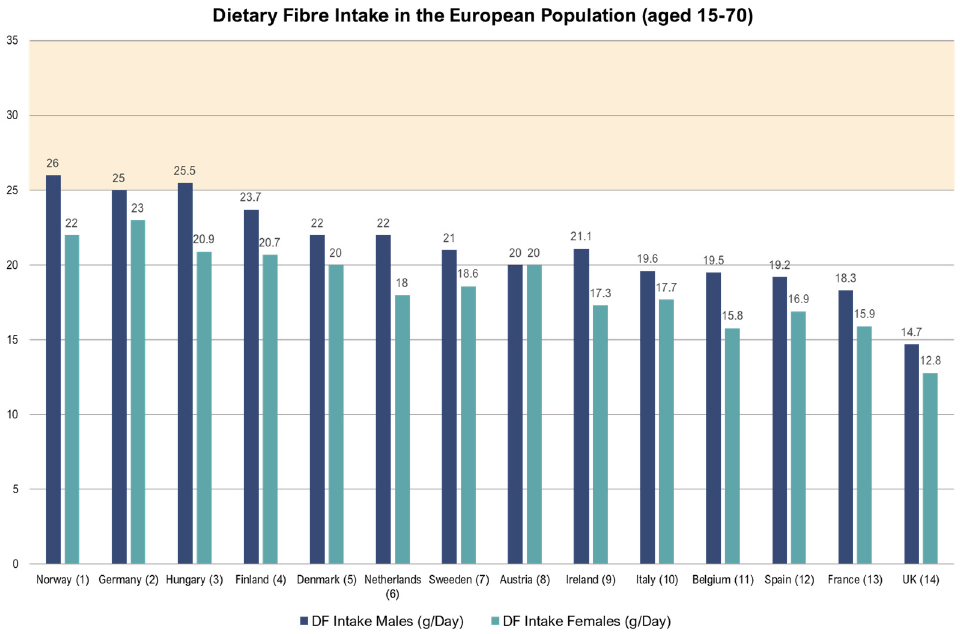
Figure 1. The daily dietary fibre intake recommended by the WHO (area shaded in yellow) is hardly met by the European adult population. This requirement is reached only in a minority of countries (i.e., Norway, Germany, and Hungary), and just by the male segment of the adult population [18–31] (Data aggregated by [14]).